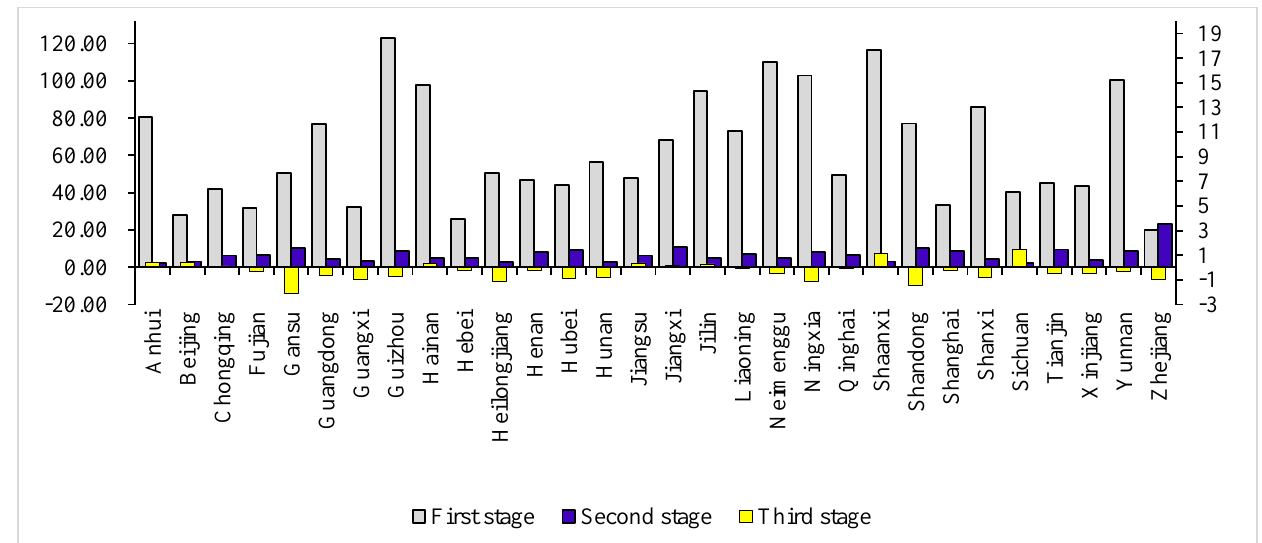
Figure 5. Spatial pattern of average growth index of land finance of the thirty provinces in stages one, two, and three.